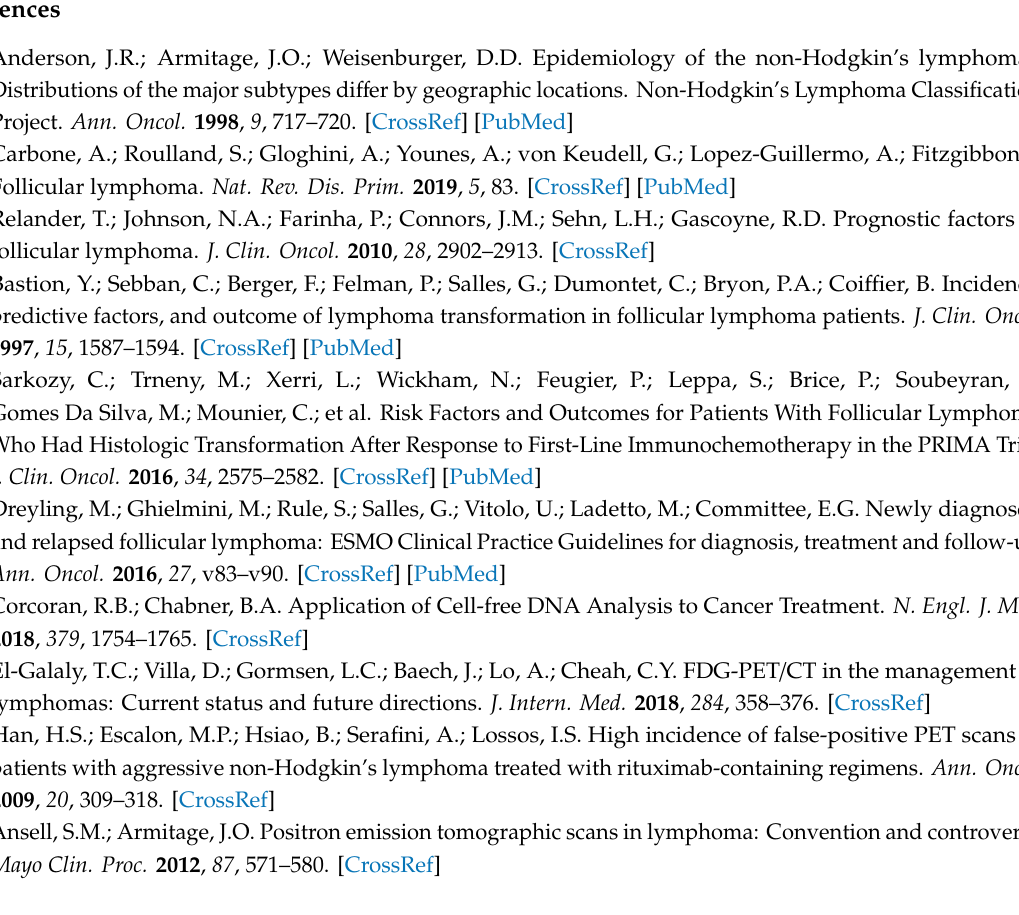
Table S1: Detailed clinical characteristics of Patient